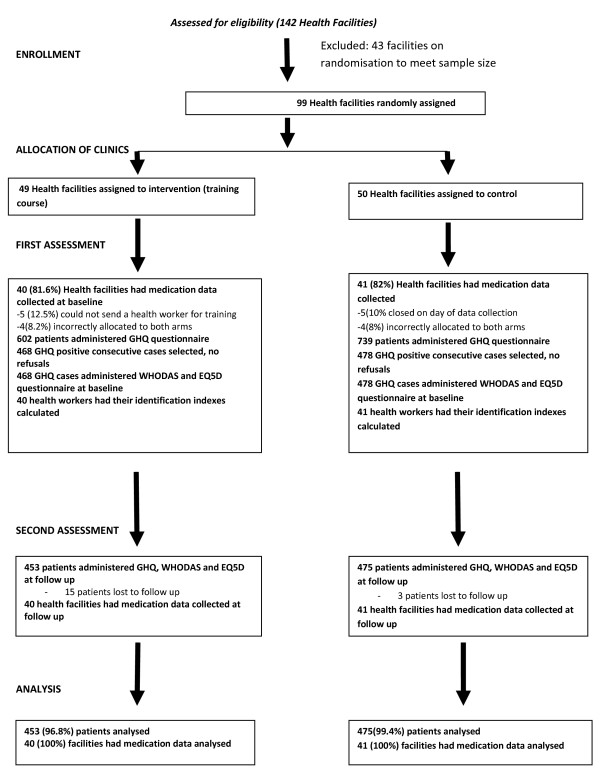
Flow chart of trial.